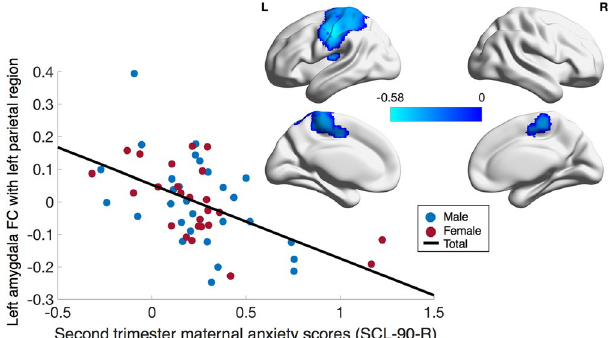
Figure 2. Relationship between maternal prenatal anxiety and amygdala functional connectivity. Second trimester SCL-90-R scores were negatively correlated with functional connectivity between the left amygdala and one large cluster encompassing several brain regions shown in blue (rho = − 0.50, p = 1.2 × 10 –4 ). This effect was seen when controlling for child’s age at the scan, sex, birth weight, gestational age at birth, household income, and maternal prenatal depressive symptoms. The data plotted are residuals of anxiety scores and cluster-averaged left amygdala functional connectivity after accounting for covariates. Results were corrected for multiple comparisons at voxelwise and cluster p < 0.05 (cluster size: 2857 voxels; Peak: − 49, − 23, 36—left inferior parietal lobule) (N =